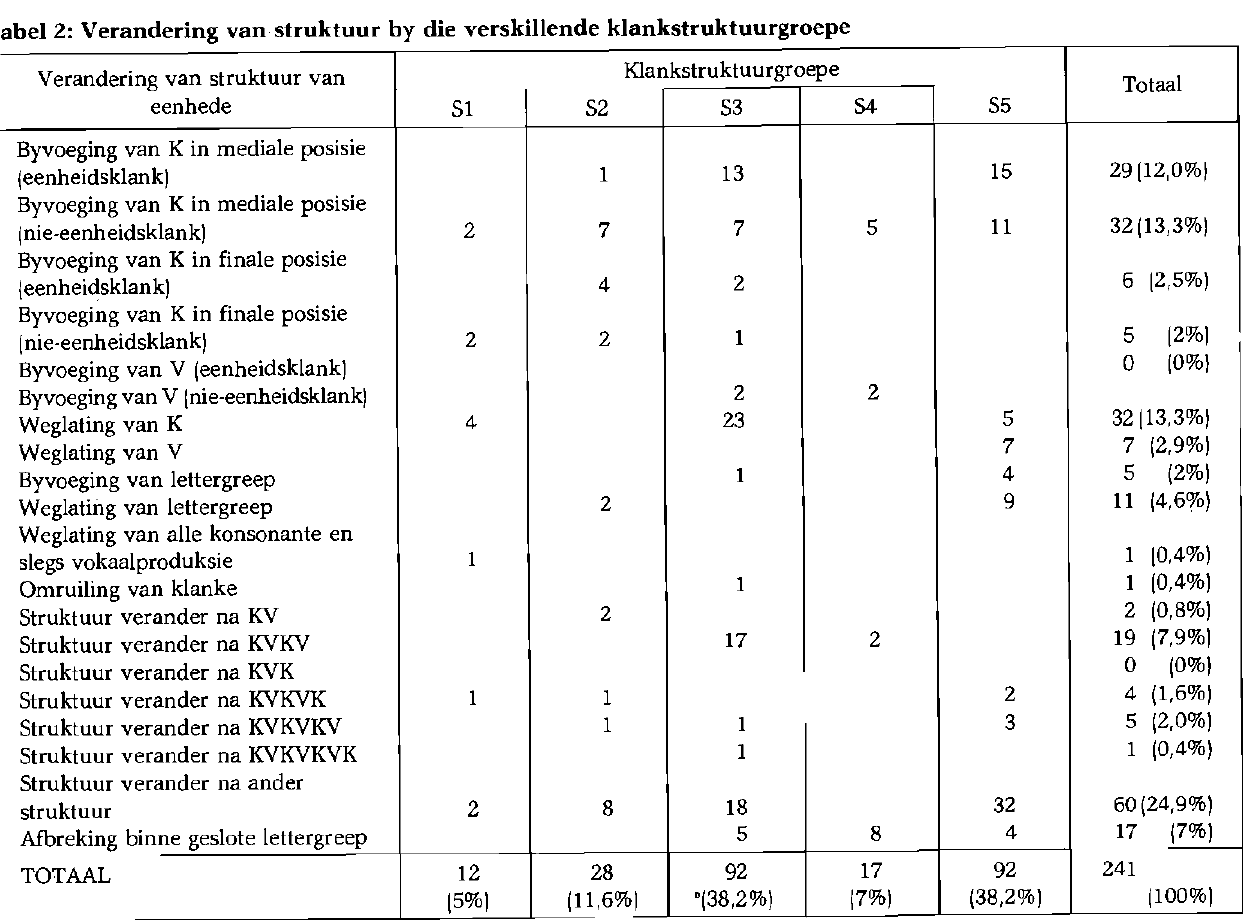
Ouditief Waarneembare Foute by Verbale Apraksie: Aanduidings van die Aard van die Afwyking Tabel 2: Verandering van struktuur by die verskillende klankstruktuurgroepe Verandering van struktuur